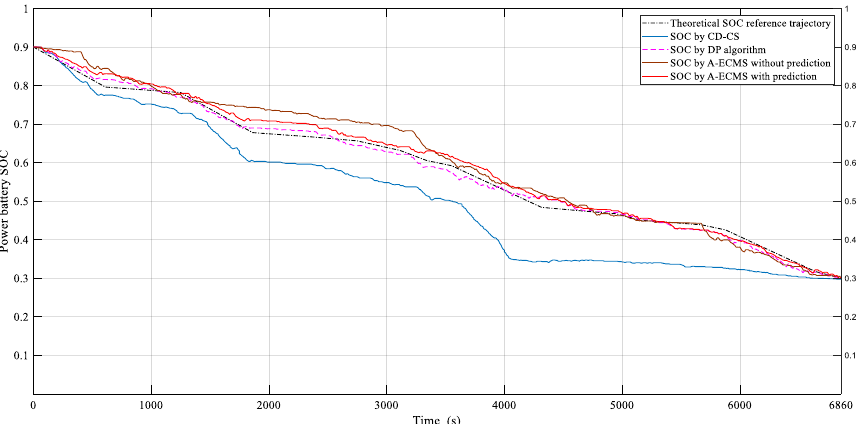
Figure 13. The cycle condition identification result.